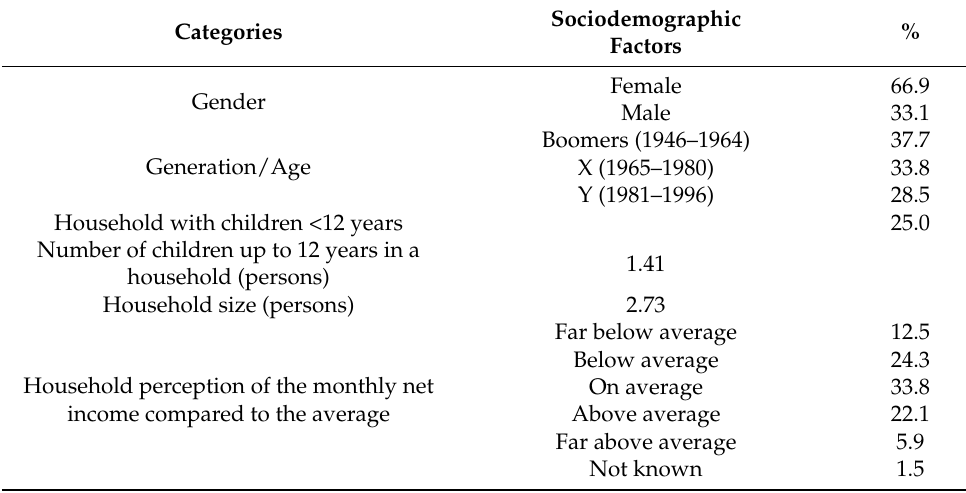
Table 1. Sociodemographic characteristics of respondents.